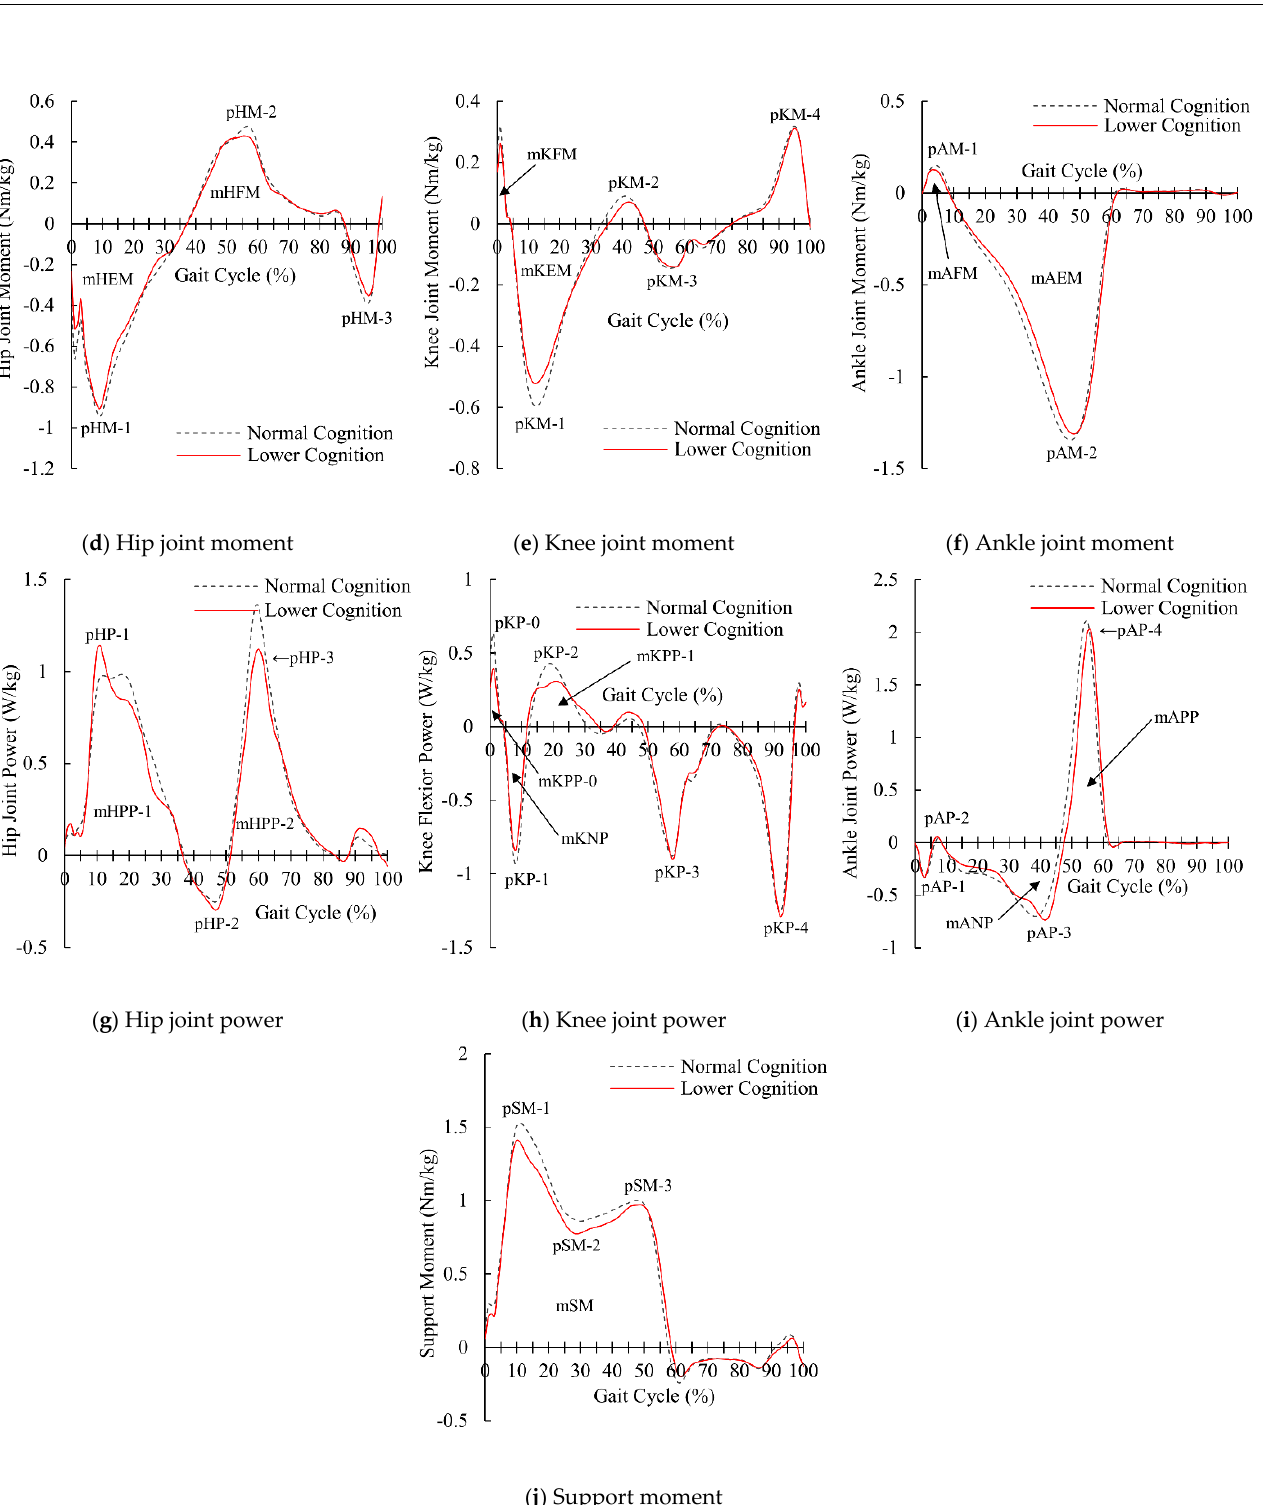
Figure 1. Profiles of the joint biomechanics of the two groups. ( a ) Hip joint angle; ( b ) knee joint angle; ( c ) ankle joint angle; ( d ) hip joint moment; ( e ) knee joint moment; ( f ) ankle joint moment; ( g ) hip joint power; ( h ) knee joint power; ( i ) ankle joint power; ( j ) support moment. A positive value in the profiles of the joint angle and joint moment indicates joint flexion and joint flexor moment, respectively; a positive value in the profiles of joint power and support moment indicates energy generation and the sum of the extensor moment, respectively.